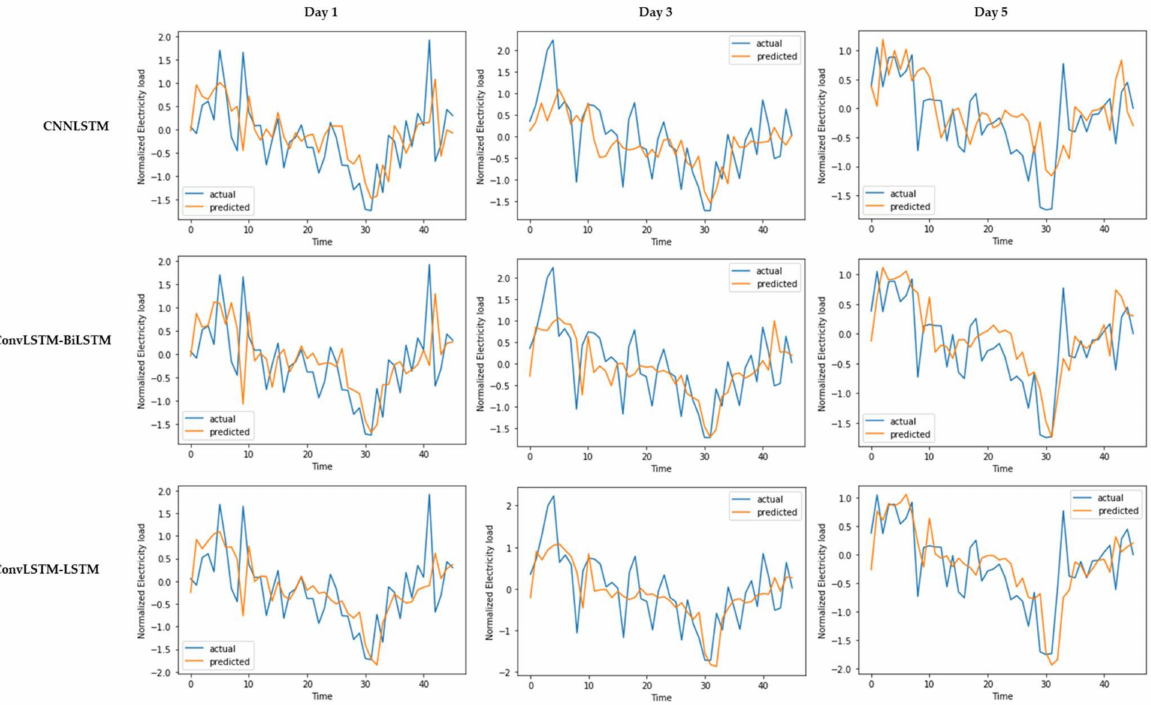
Figure 12. Daily total actual consumption vs. prediction results over a test samples for different days in a week with UCI household electricity dataset.